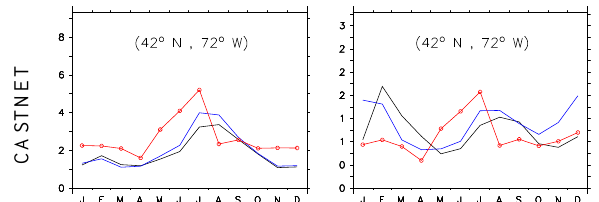
(left), and 4 Fig. 17. Temporal correlation of observations from CASTNET, EMEP and EANET and model results for the year 2005 of NH + Upper: model results from simulation ST; lower: model results from simulation